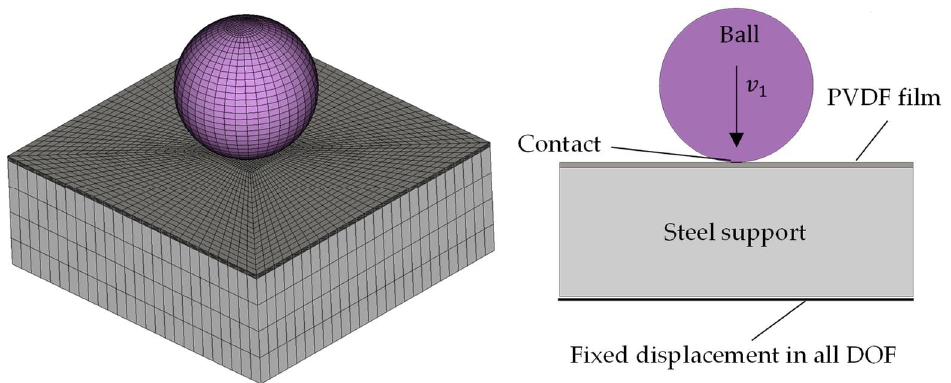
Figure 12. FEM model for the simulation of the ball drop. Table 1. The considered mechanical properties for the analytical and numerical solution.